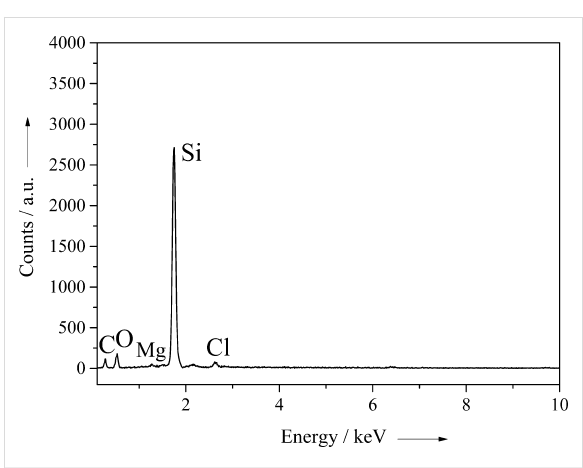
Figure 7: EDX spectra of Synura petersenii after conversion into silicon. The EDX spectra of Mallomonas caudata shows almost iden- tical